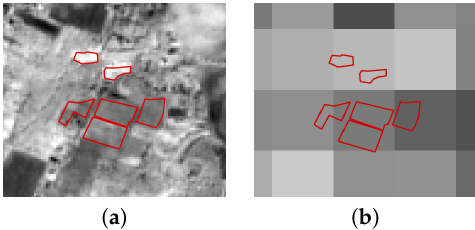
Figure 1. Digitalized grasslands (in red) from the dataset used in this study on ( a ) a Sentinel-2 image (10-m pixel resolution) and ( b ) a MODIS image (250